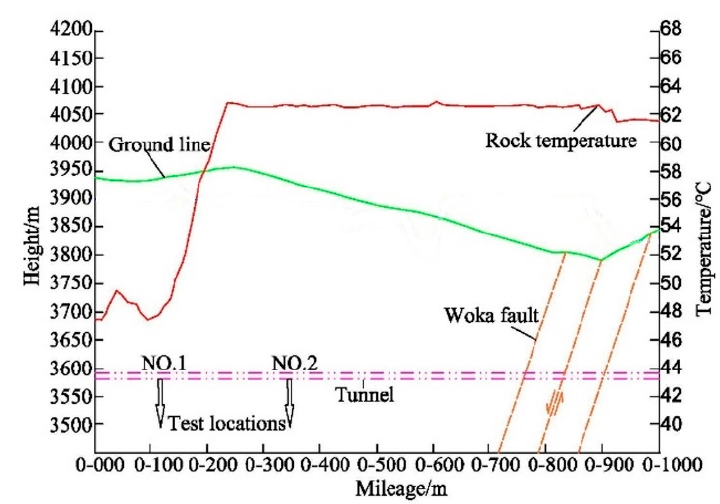
Figure 4. Environmental characteristics of the tunnel.